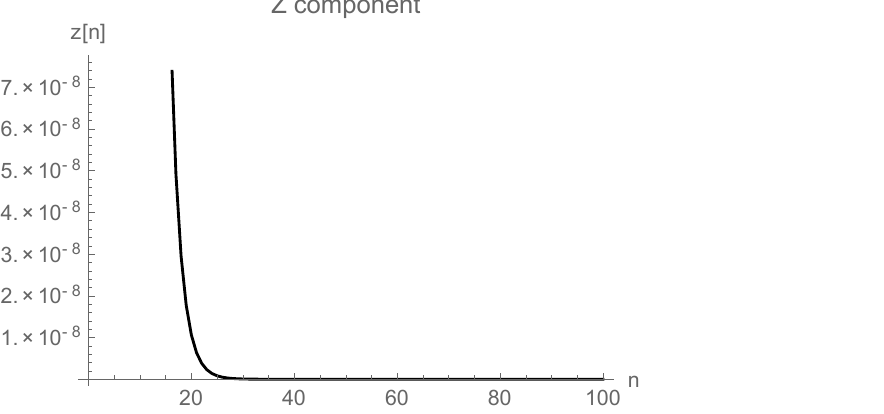
Figure 17. Graph of z n for α = 0.5, β = 1.7, γ = 1.6, δ = 0.3, ζ = 0.7, η = 1.6, µ = 2.7, ε = 0.6, υ = 0.8, ρ = 1.11, σ = 1.11, ω = 0.2. with initial conditions x 0 = 0.002, y 0 = 0.0084 and z 0 = 0.0003.